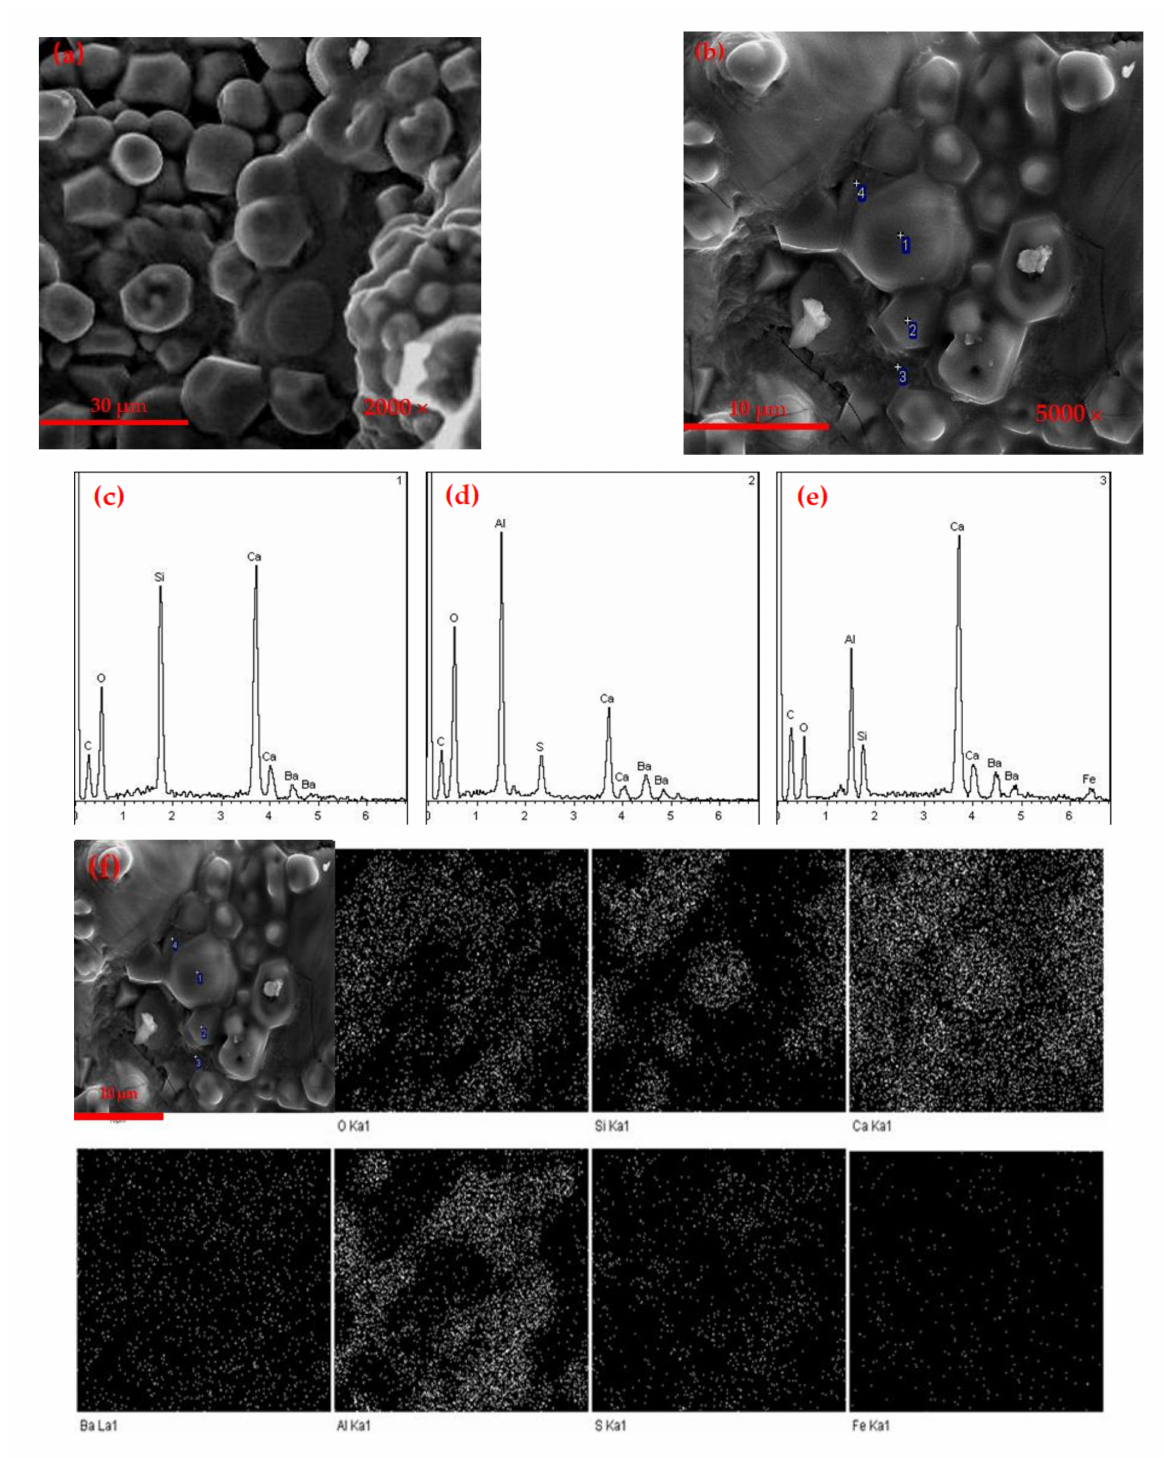
Figure 5. SEM-EDS photographs of ( a , b ) CAF5 clinker, ( c ) 1-EDS, ( d ) 2-EDS, ( e ) 3-EDS, ( f ) scanning photograph of the cement clinker